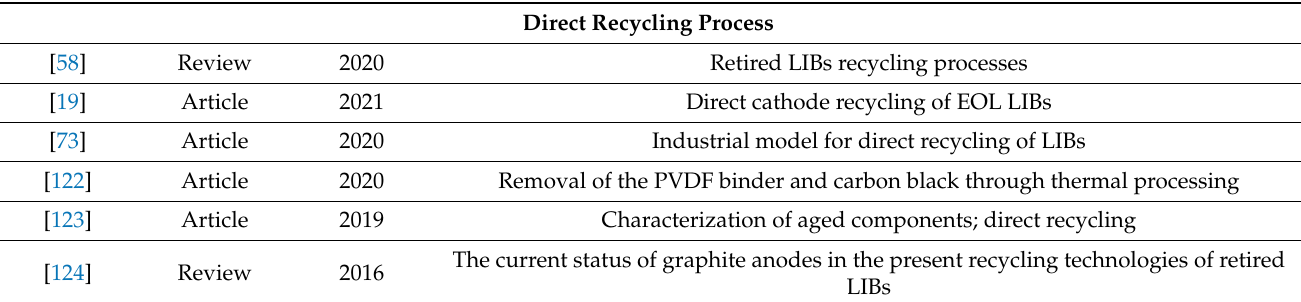
Table A5. Assessed literature in review for “Direct Recycling Process”